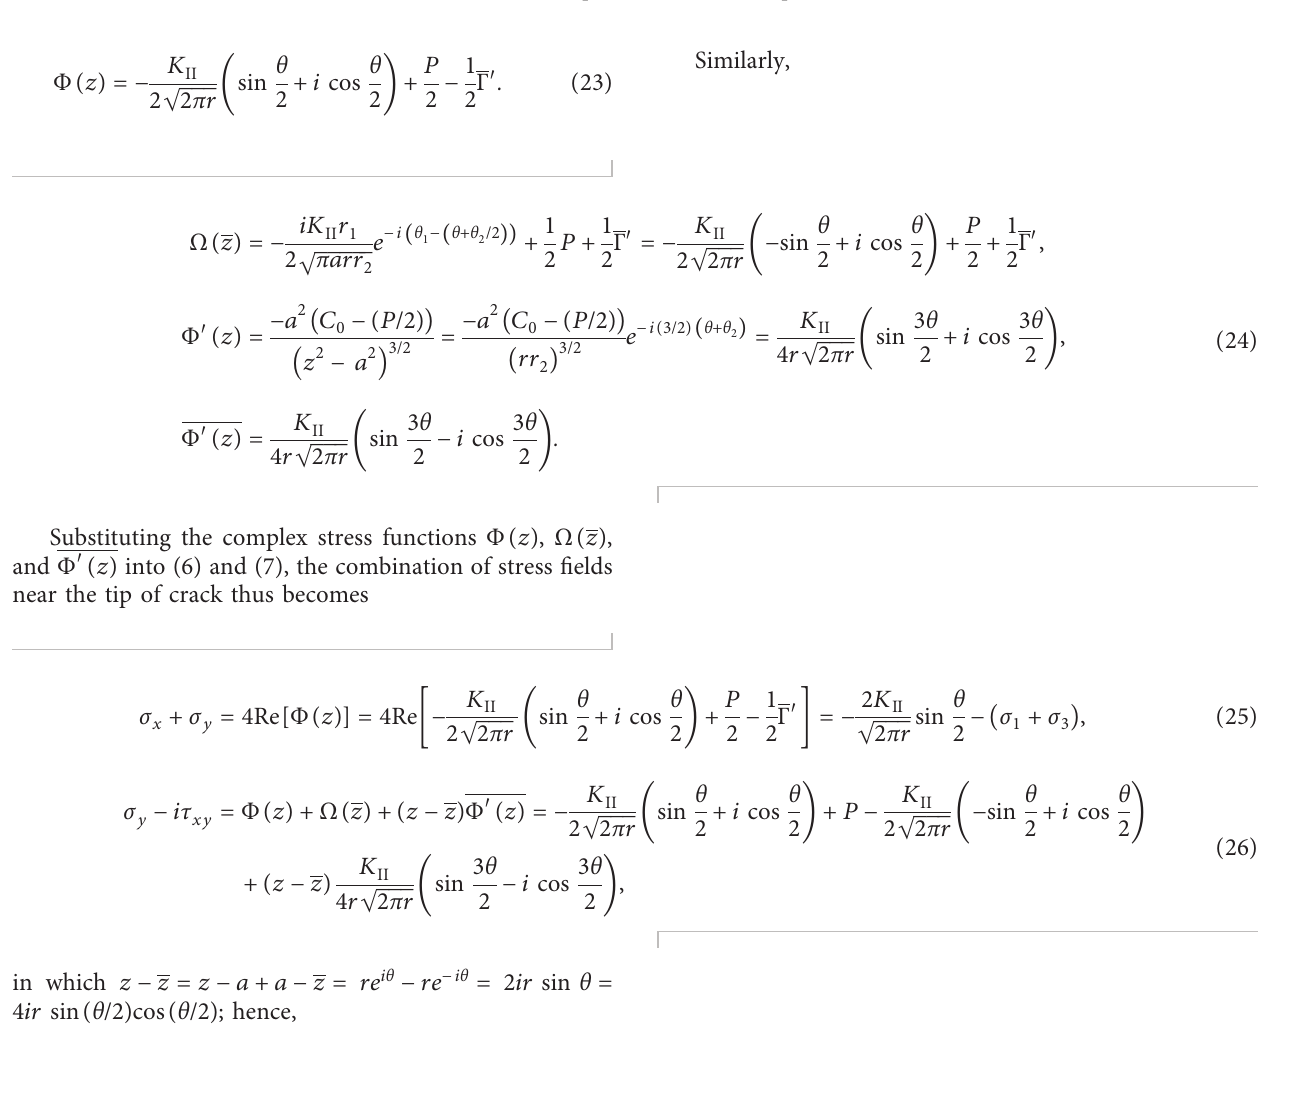
Figure 3: The crack in complex coordinates and polar